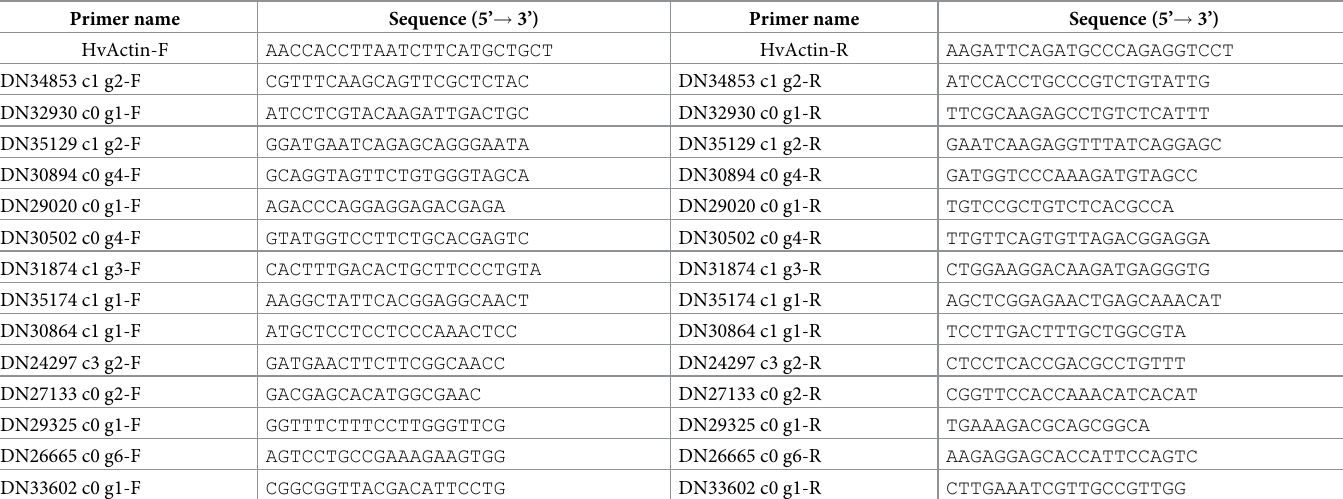
Table 1. Primers of the qRT-PCR verification